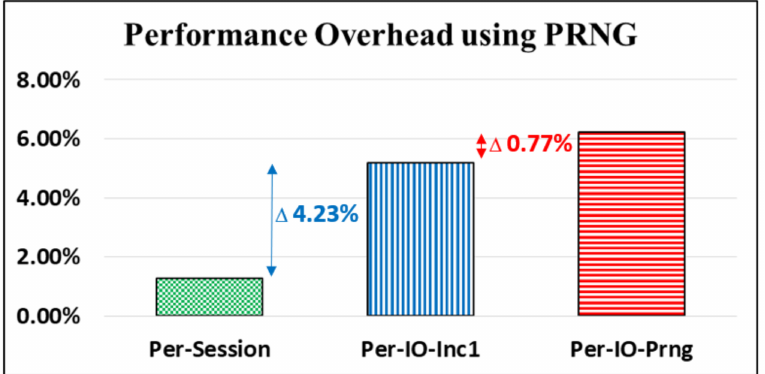
Figure 13. Latency performance comparisons among different key update